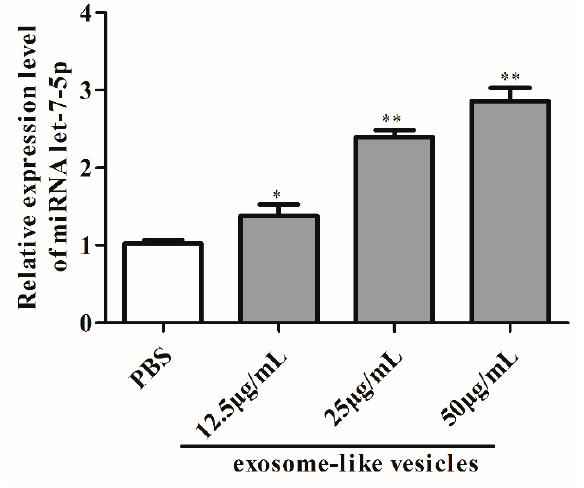
Figure 4. miR-let-7-5p expression in exosomes treated macrophages was detected by qPCR. n = 3, mean ± SD, * p < 0.05, ** p < 0.01 vs. the PBS group.